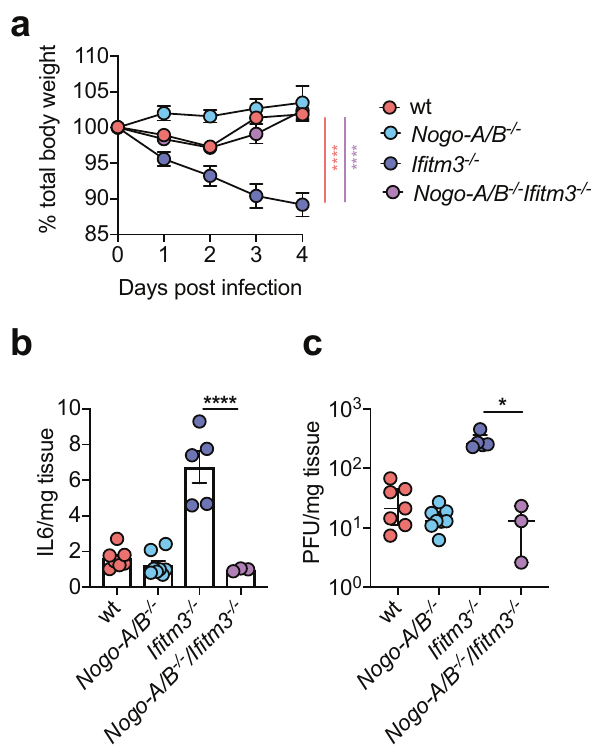
Fig. 5 | Nogo-B drives viral pathogenesis in I fi tm3 − / − mice during MCMV infec- tion. Wt( n =13), I fi tm3 − / − ( n =9), Nogo-A/B − / − ( n =14),and Nogo-A/B − / − I fi tm3 − / − ( n =9) male and female mice were infected with MCMV for 4 days. Data are merged from two independent experiments. a Weight changes were measured over time and data are shown as mean±SEM. Statistical signi fi cance between weight curves of I fi tm3 − / − and either wt (black) or Nogo-A/B − / − I fi tm3 − / − (blue) mice is shown. After 4 days, IL-6 ( b ) and virus load ( c ) in spleen homogenates were measured in wt ( n =7), Nogo-A/B ( n =8), I fi tm3 − / − ( n =5) and Nogo-A/B − / − I fi tm3 − / − ( n =3) mice. Data are representative of two experiments and are shown as mean±SEM ( b ) or indi- vidual mice+median and inter-quartile range ( c ). Statistical signi fi cance was assessed using two-way ANOVA ( a ) or one-way ANOVA analysis with Tukey ’ s mul- tiplecomparisonstest( b , c ). p valuesarereportedasfollows:n.s.,>0.05;*, ≤ 0.05;**, ≤ 0.01; ***, ≤ 0.001. Source data are provided as a Source Data fi